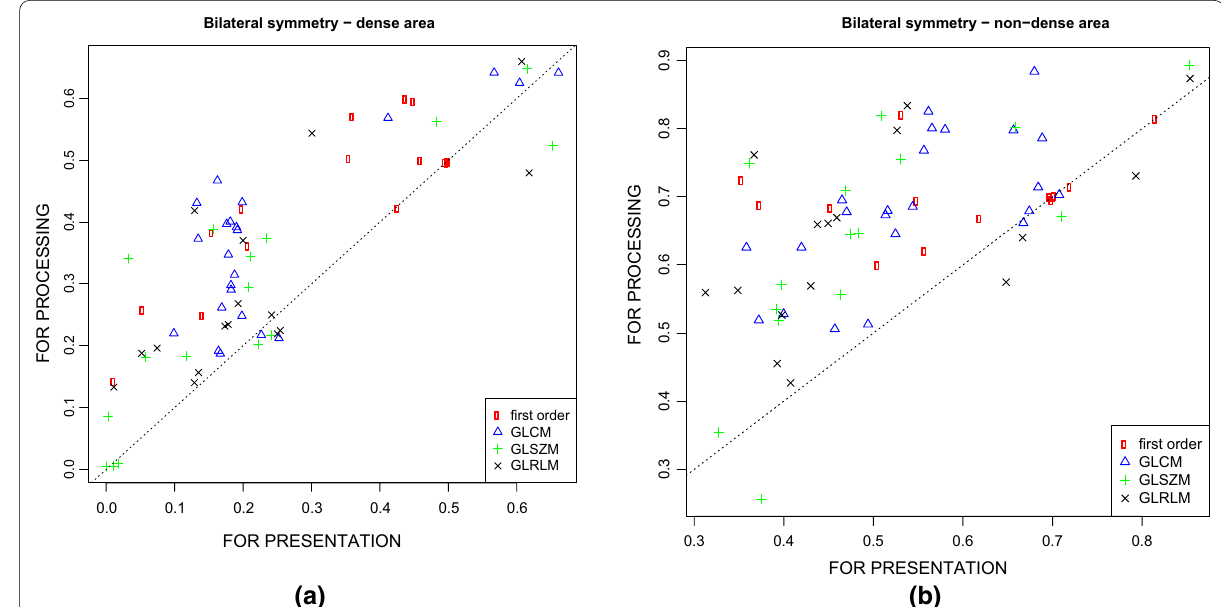
Fig. 4 Feature bilateral symmetry on dense area ( a ) and on non-dense area ( b ). Per each feature, computed both on FOR PROCESSING and on FOR PRESENTATION, ICC between left and right breast has been evaluated. Each marker in the plot represents a feature; dotted identity line is reported as a reference. Markers appear to lie mainly above the identiy line suggesting bilateral symmetry is higher when evaluated on features computed using FOR PROCESSING images